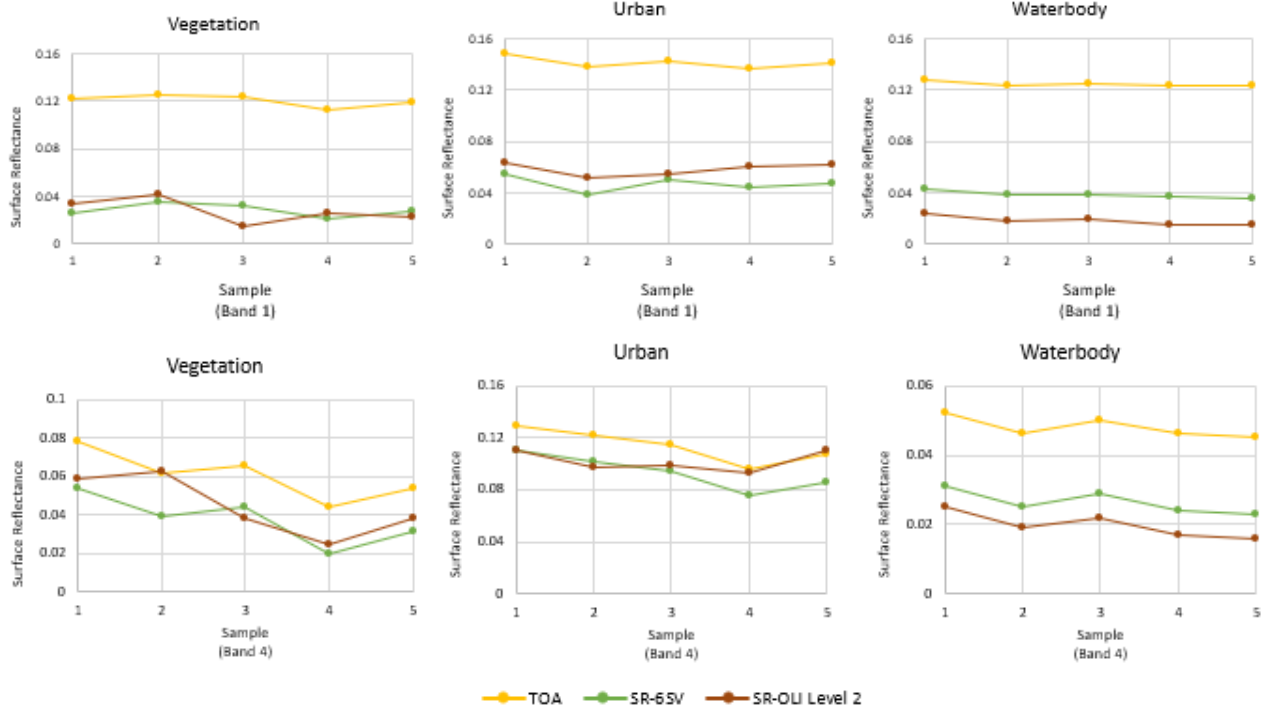
Fig. 4. SR comparison of different objects in coastal aerosol and red band